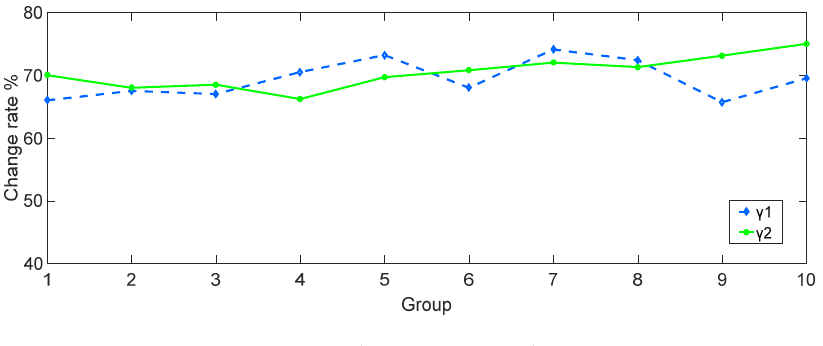
Figure 3. Change rate γ 1 and γ 2.